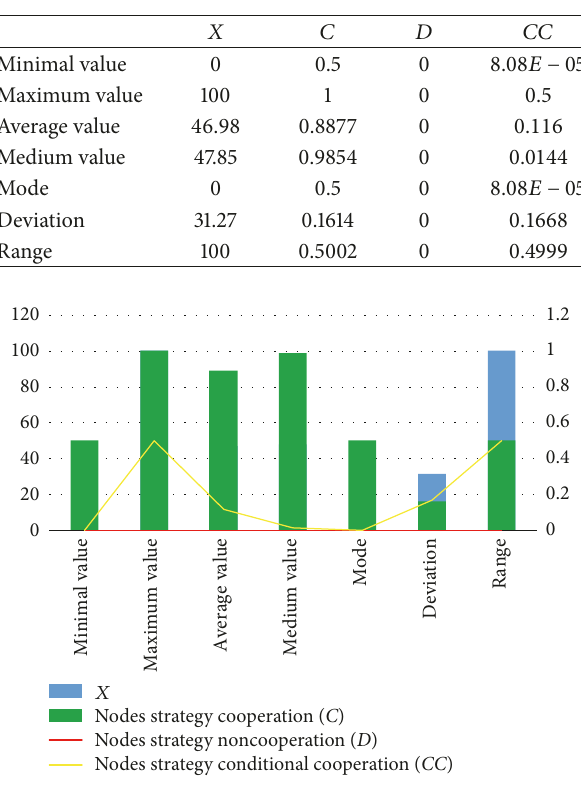
Table 5: The statistical analyses of strategies 𝐶 , 𝐷 , and 𝐶𝐶 .